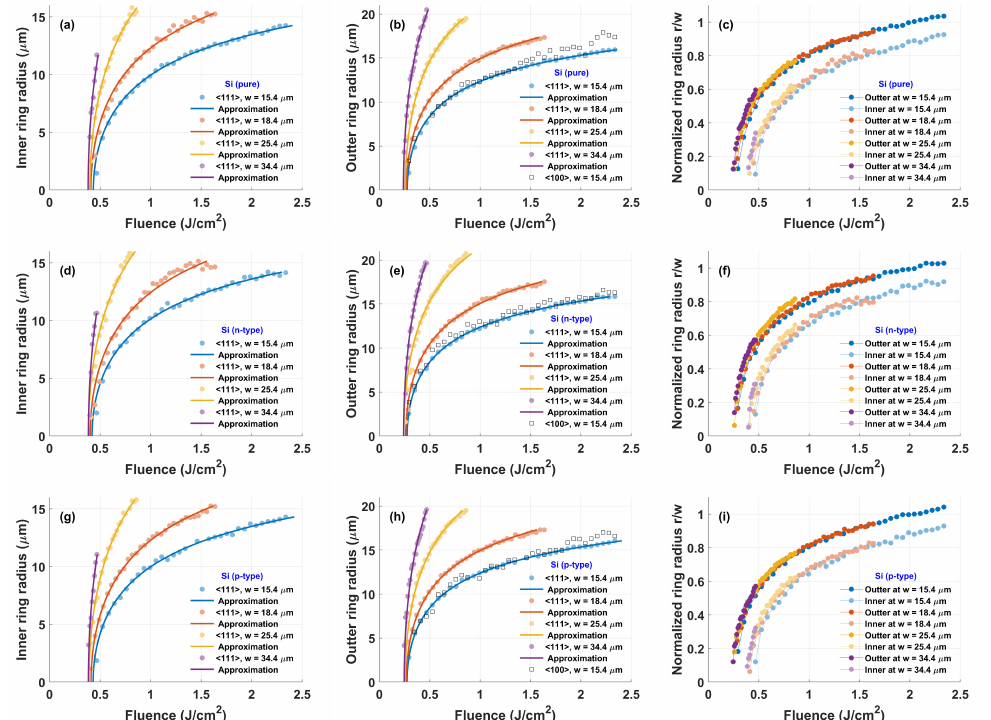
Figure 3. The inner ( a , d , g ), outer ( b , e , h ), and normalized ( c , f , i ) radii dependence on the fluence of laser pulse and beam focusing conditions. Circles depict the Si (cid:104) 111 (cid:105) crystal orientation while squares depict the Si (cid:104) 100 (cid:105) crystal orientation. The points correspond to the experimental measurements and the solid line to the approximation F ( d – f ) n-type, ( g – i )